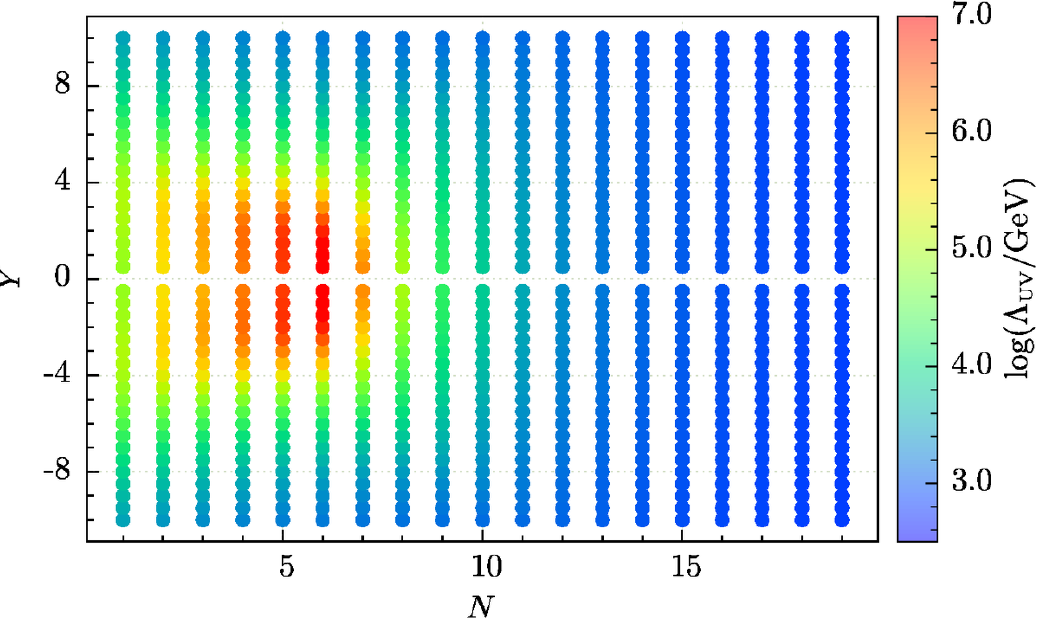
Figure 4 . Largest possible UV scale in extensions of the conformal SM by one complex SU(2) L N -plet with hypercharge Y and vanishing